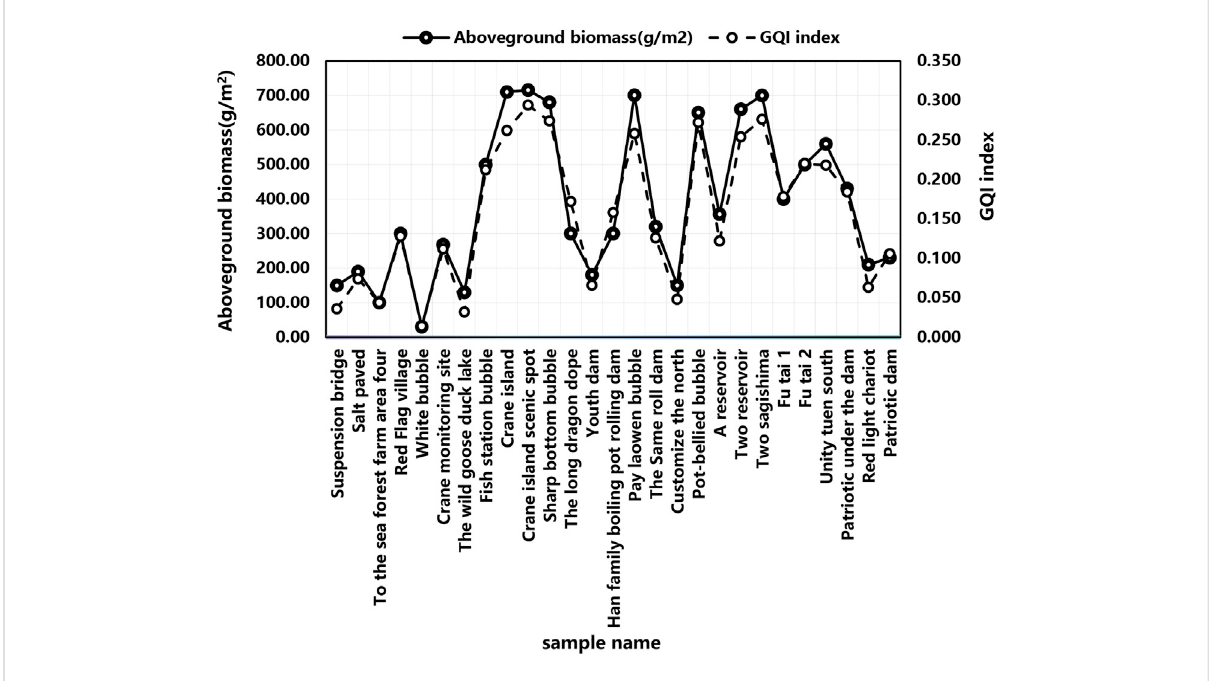
FIGURE 6 The graph of two vertical